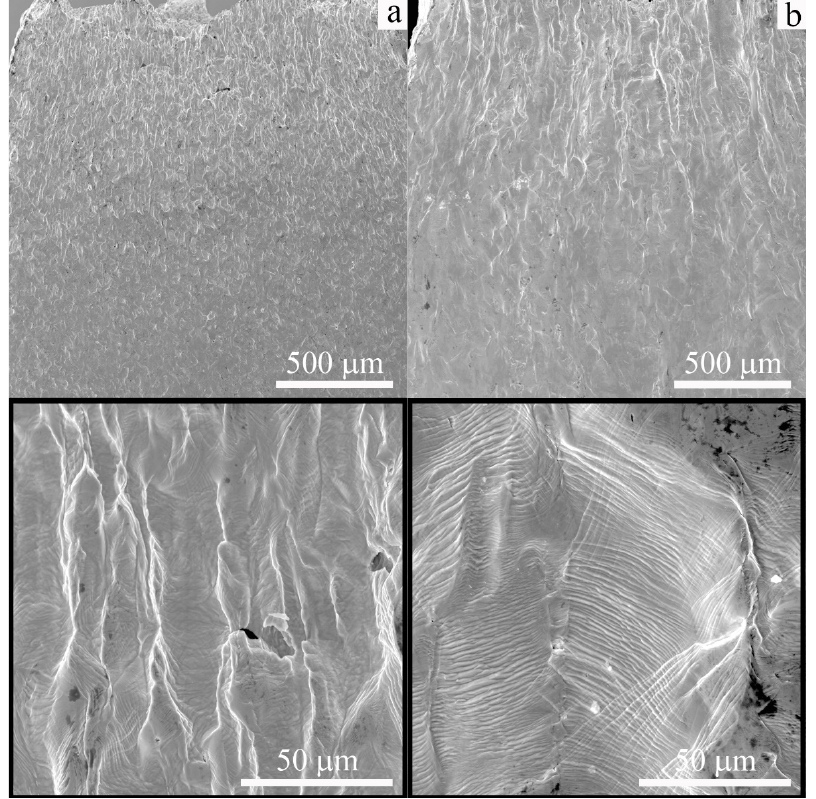
Figure 6. SEM images of the lateral surfaces of the low-carbon steel: ( a ) cast and ( b ) EBAM. Specimens were tensile tested to failure at 300 K.